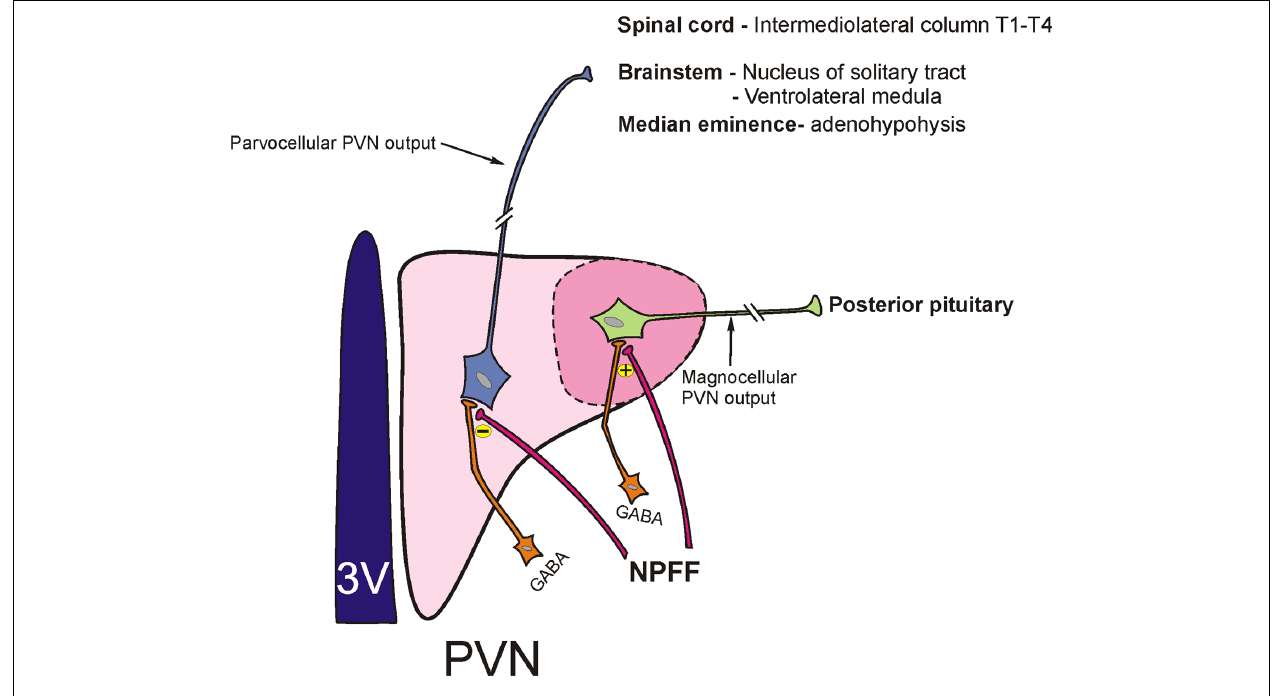
magnocellular neurons of the PVN. NPFF inhibits activity of GABAergic terminals that project to the parvocellular PVN neurons resulting in a disinhibition of these neurons. On the other hand, NPFF augments GABA synaptic input to magnocellular PVN